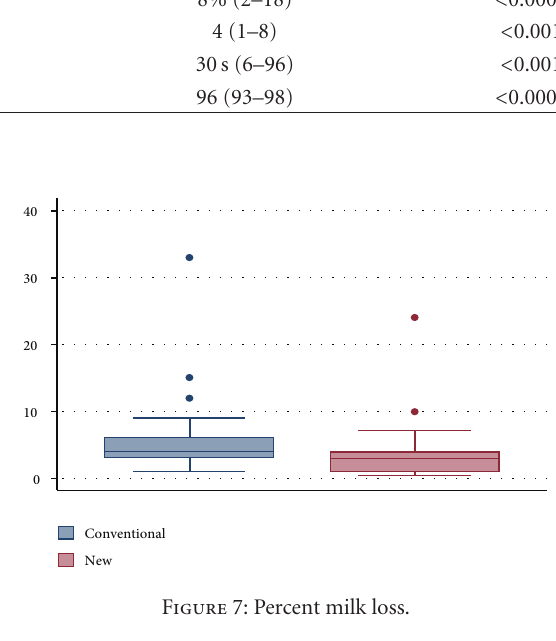
Figure 6: Rate of milk transfer (mL/min).